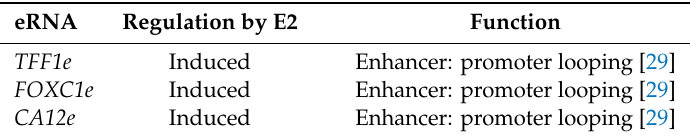
Table 1. Estrogen-regulated